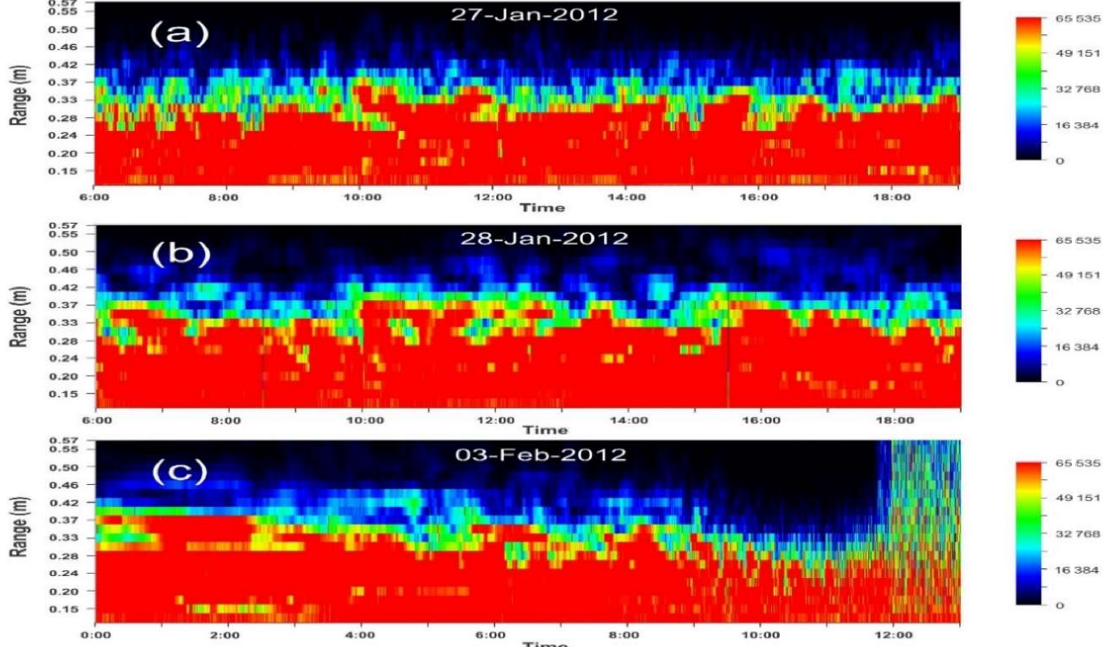
Figure 7. Zoomed-in channel 4 close-in returns acquired during 13h intervals at different stages of the interval 4 blockage event. Panels (a) and (b) depict intervals initiated at times coinciding with complete extinctions in, respectively, the high-frequency (06:00MST, 27 January) and low-frequency (06:00MST, 28 January) channels, roughly 24 and 48h into the interval. Panel (c) , initiated at 00:00MST on 3 February, terminates with a blockage-ending ice clearance